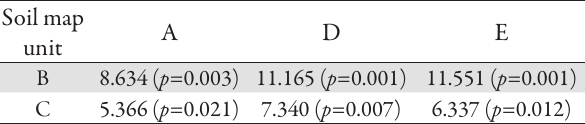
Tab. 4. Multiple comparison between percentage cover of vegetation and soil map unit* Soil map C: Typic Xerorthents, Fine loamy over Loamy Skeletal; D: Rock & Lithic Xerorthents, Loamy Skeletal; E: Lithic Xerorthents, Loamy Skeletal & Typic Xerorthents